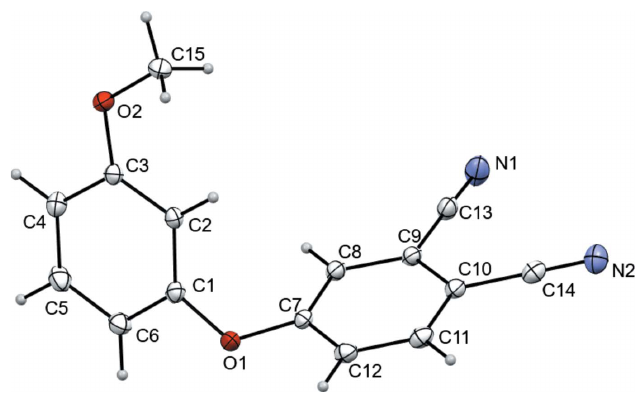
Figure 1 The molecular structure of o -4-(3-methoxy phenoxy)phthalonitrile, showing the atom labeling. Displacement ellipsoids are drawn at the 50% probability level.